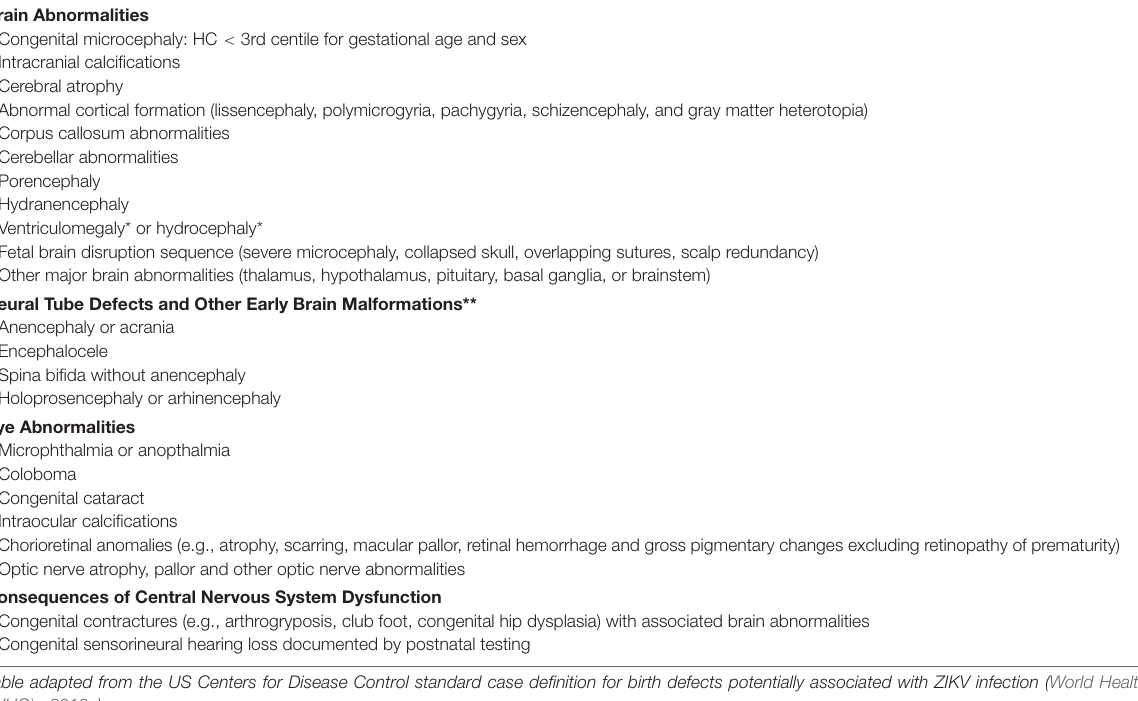
Table adapted from the US Centers for Disease Control standard case definition for birth defects potentially associated with ZIKV infection (World Health Organization (WHO)., 2018a). *Excludes isolated mild ventriculomegaly without other brain abnormalities or hydrocephalus due to hemorrhage. **Evidence for a link between ZIKV infections and neural tube defects is weaker than for other listed anomalies. specialized brain region important for learning,